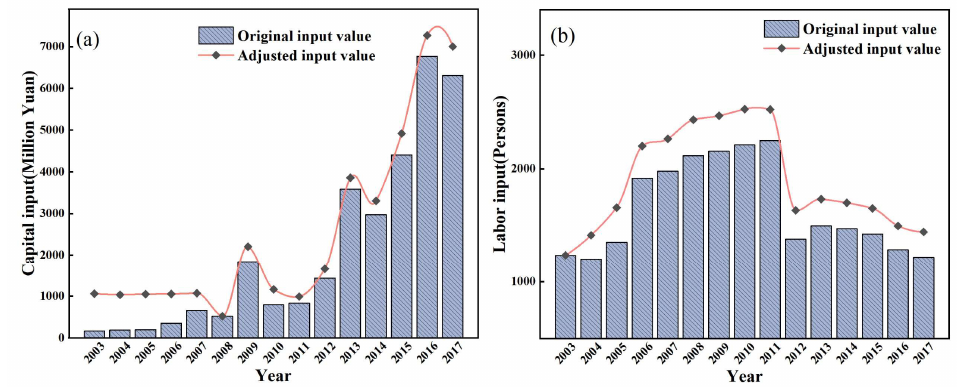
Figure 7. Comparison of the original and adjusted capital ( a ) and labor ( b ) inputs of water pollution control.